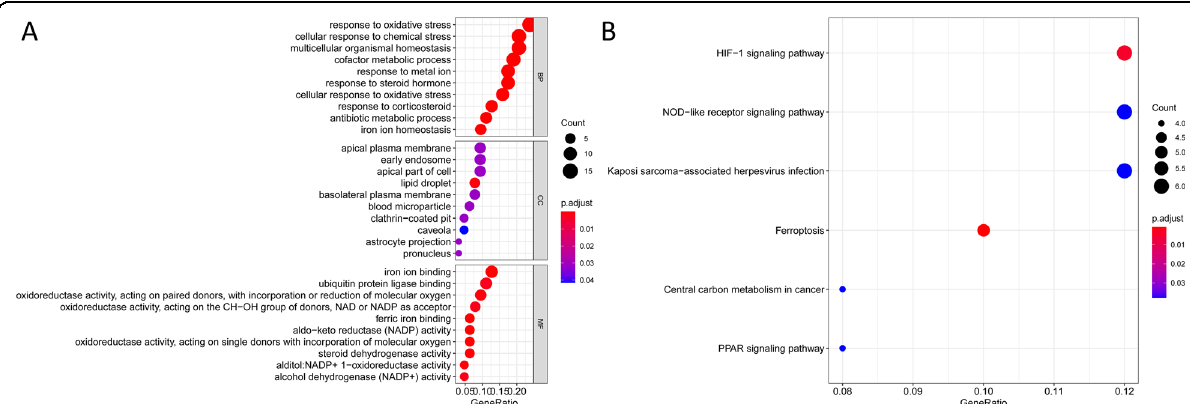
Fig. 1 Gene ontology (GO) and Kyoto Encyclopedia of Genes and Genomes (KEGG) outcomes of ferroptosis-related genes through the R language “ ggplot2 ” and “ org.Hs.eg.db ” package (adjust p value <0.05). The org.Hs.eg.db package implements the conversion between gene symbols and entrezIDs based on mget function. The X -axis represents the gene ratio, that is, the number of genes enriched in each GO/the total number of genes and the Y -axis represents the speci fi c function or pathway that is enriched. The size of the circle represents the number of genes enriched on each GO, and the redder the color represents the higher the degree of enrichment on GO. A GO; B KEGG. (BP: biological processes, MF: molecular functions, CC: cellular